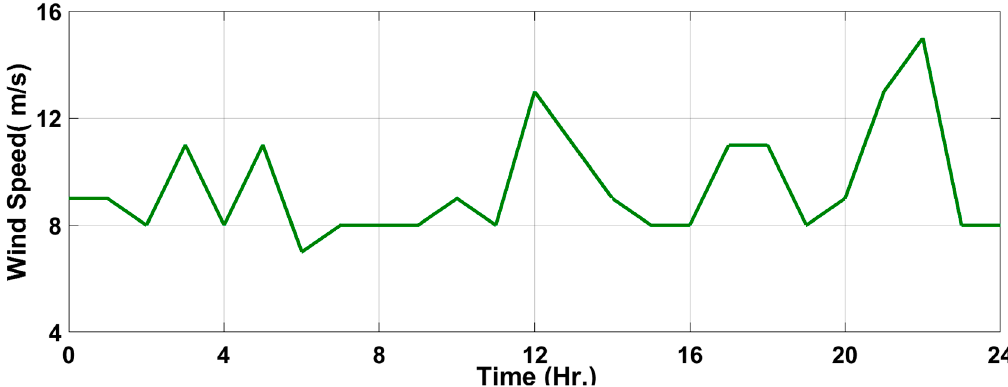
Figure 6. Wind speed profile.